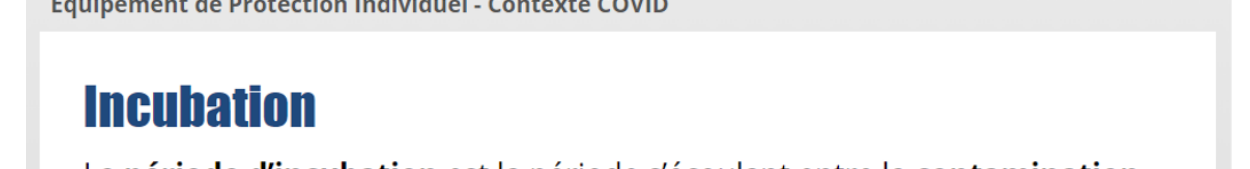
Figure 4. Response when the second answer attempt is also unsuccessful. Immediate feedback is provided, showing the right answer and other relevant information. The learner can now click on Continuer (Continue) to move